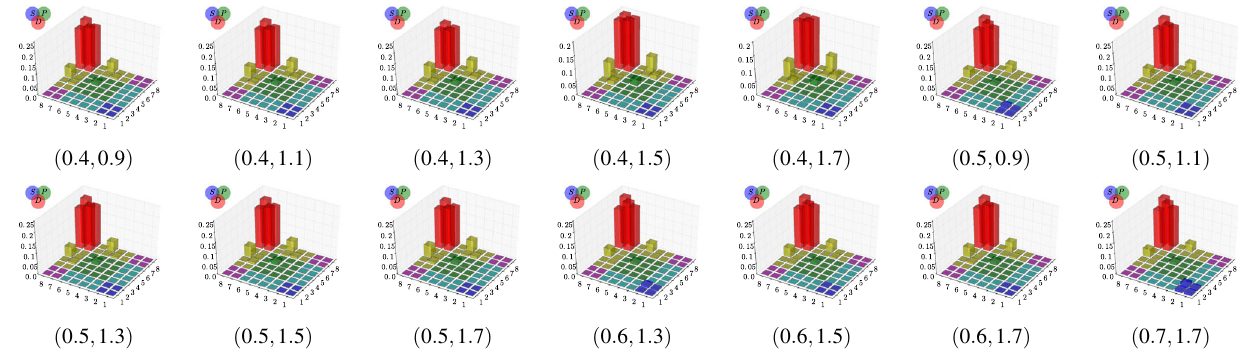
Fig. 12 Orbital angular momentum decomposition of first 1 −− excitation where available on our ω − D grid. The particular (ω, D ) pair is given below each subfigure omitting units for brevity. Axes and colors as in Fig.